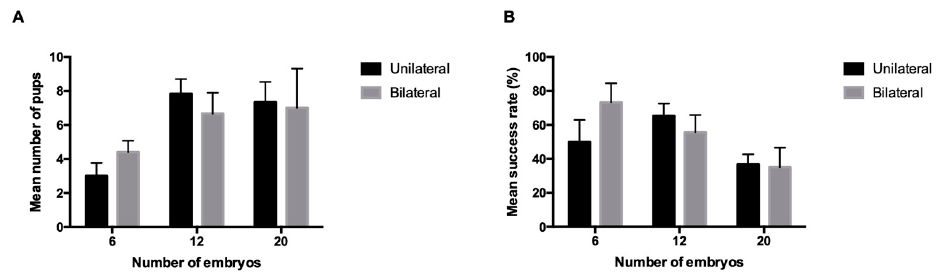
Figure 3. ( A ) Mean number of pups after unilateral and bilateral transfer for B6129F1 transfer groups (6, 12 and 20 embryos); ( B ) success rates for unilateral and bilateral transfer for B6129F1 transfer groups (6, 12 and 20 embryos). Values are mean ± SEM. No statistically significant differences were found between the